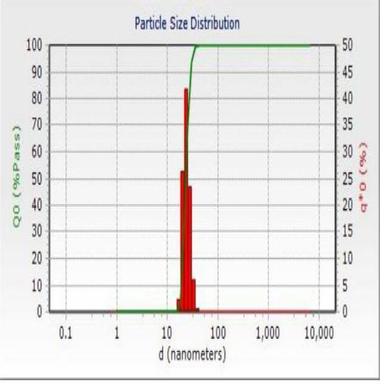
Particle size distribution curve for nanocellulose of bamboo fibers.